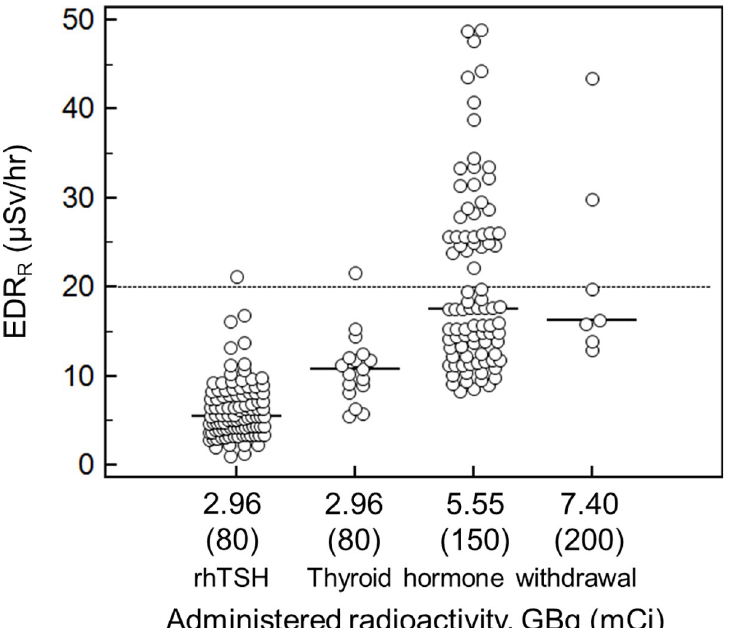
Fig 1. The effective dose equivalent rate at release (EDR R , day 2 after 131 I administration) at 1 m according to the administered radioactivities. The dotted line represents a threshold providing the instruction on radiation